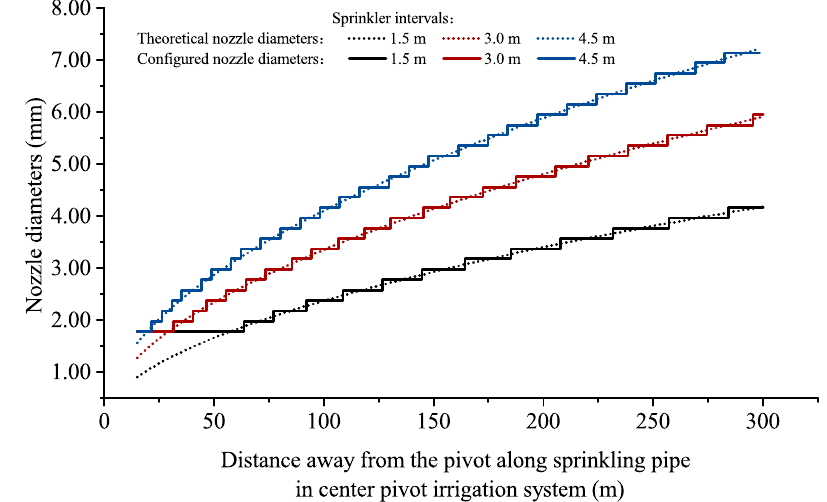
Figure 3. Nozzle configuration for the simulated center pivot irrigation system with different sprinkler intervals: 1.5, 3.0, and 4.5 m. intervals: 1.5, 3.0, and 4.5